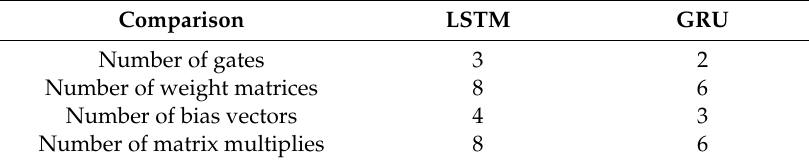
Figure 7. The proposed series network structure. Table 3. The Comparison of LSTM with GRU Trainable Parameters.